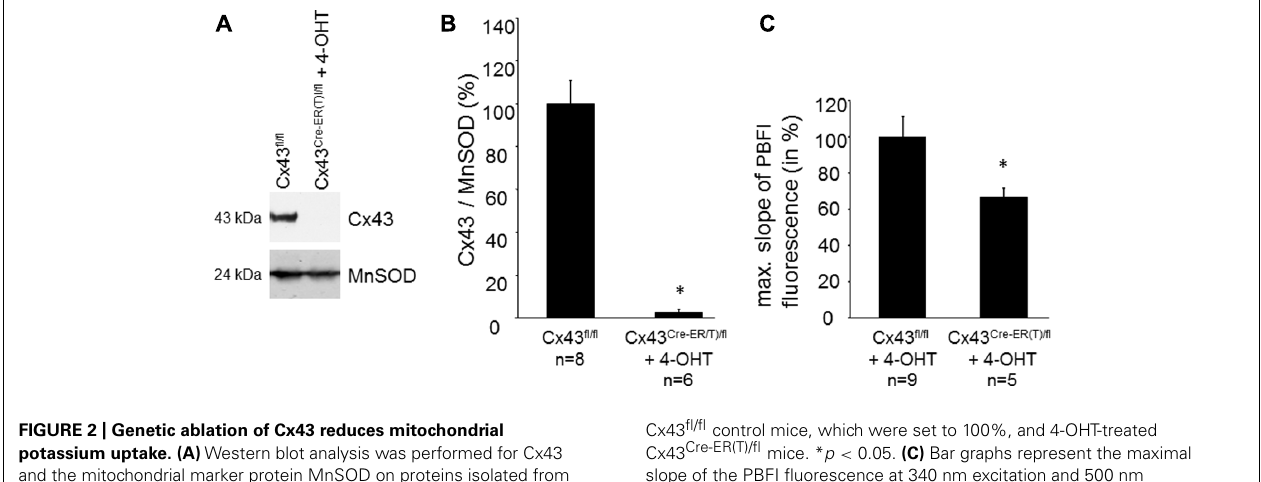
FIGURE 2 | Genetic ablation of Cx43 reduces mitochondrial potassium uptake. (A) Western blot analysis was performed for Cx43 and the mitochondrial marker protein MnSOD on proteins isolated from SSM of Cx43 fl/fl and Cx43 Cre-ER(T)fl + 4-OHT mice. (B) Bar graphs represent the mitochondrial Cx43 content normalized to MnSOD in